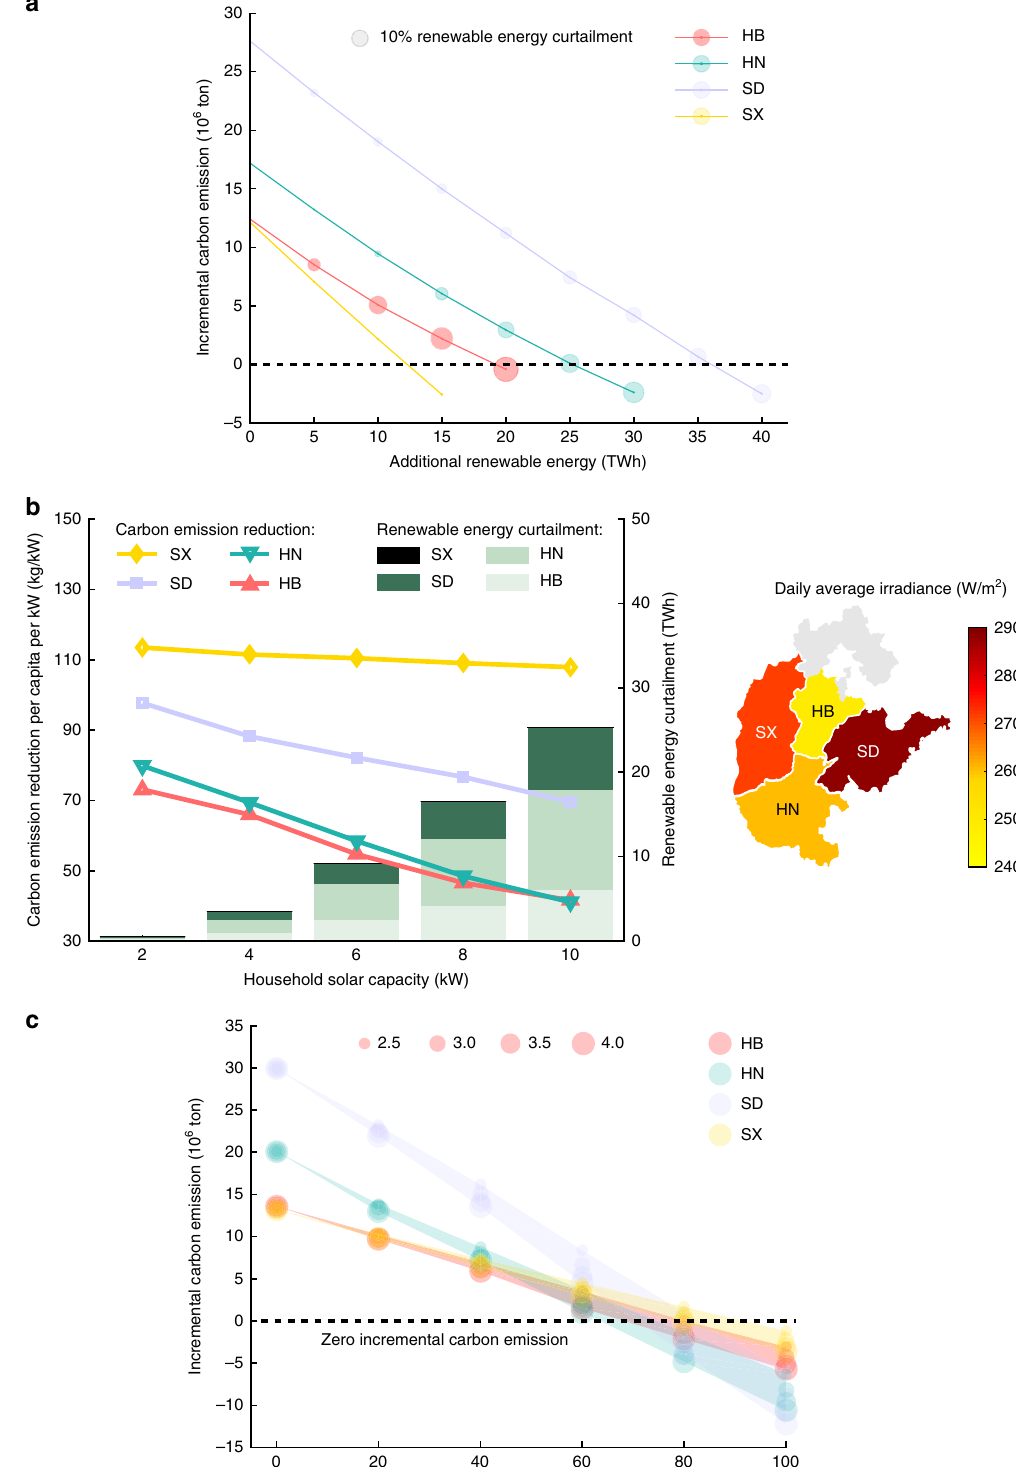
Fig. 4 Impacts of the integration of renewable energy and the improvement of electric heating devices. a Carbon emissions in Hebei (HB), Henan (HN), Shandong (SD), and Shanxi (SX) with the integration of renewable energy. The radius of each bubble represents the curtailment rate for additional renewable energy, and the center indicates the incremental carbon emission caused by electric heating. b Carbon emission reduction capability of distributed PV in the four provinces. The lines represent the carbon emission reduction per capita per kW, and the bars show the curtailment of solar energy. c Relationship between carbon emission and the proportion of heat pumps (HPs) used for electric heating. The radius of each bubble represents the coef fi cient of performance (COP) of an HP, and the shadows are bounded by the lines with COP equaling 2.5 and